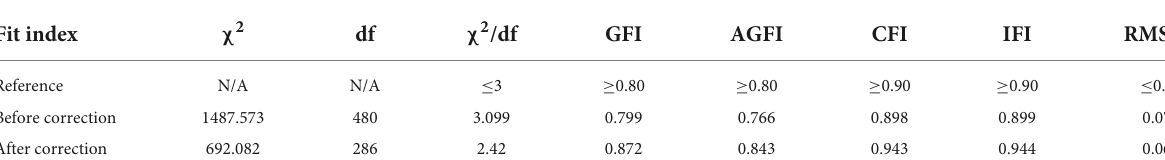
TABLE 8 Fitting index before and after model correction.